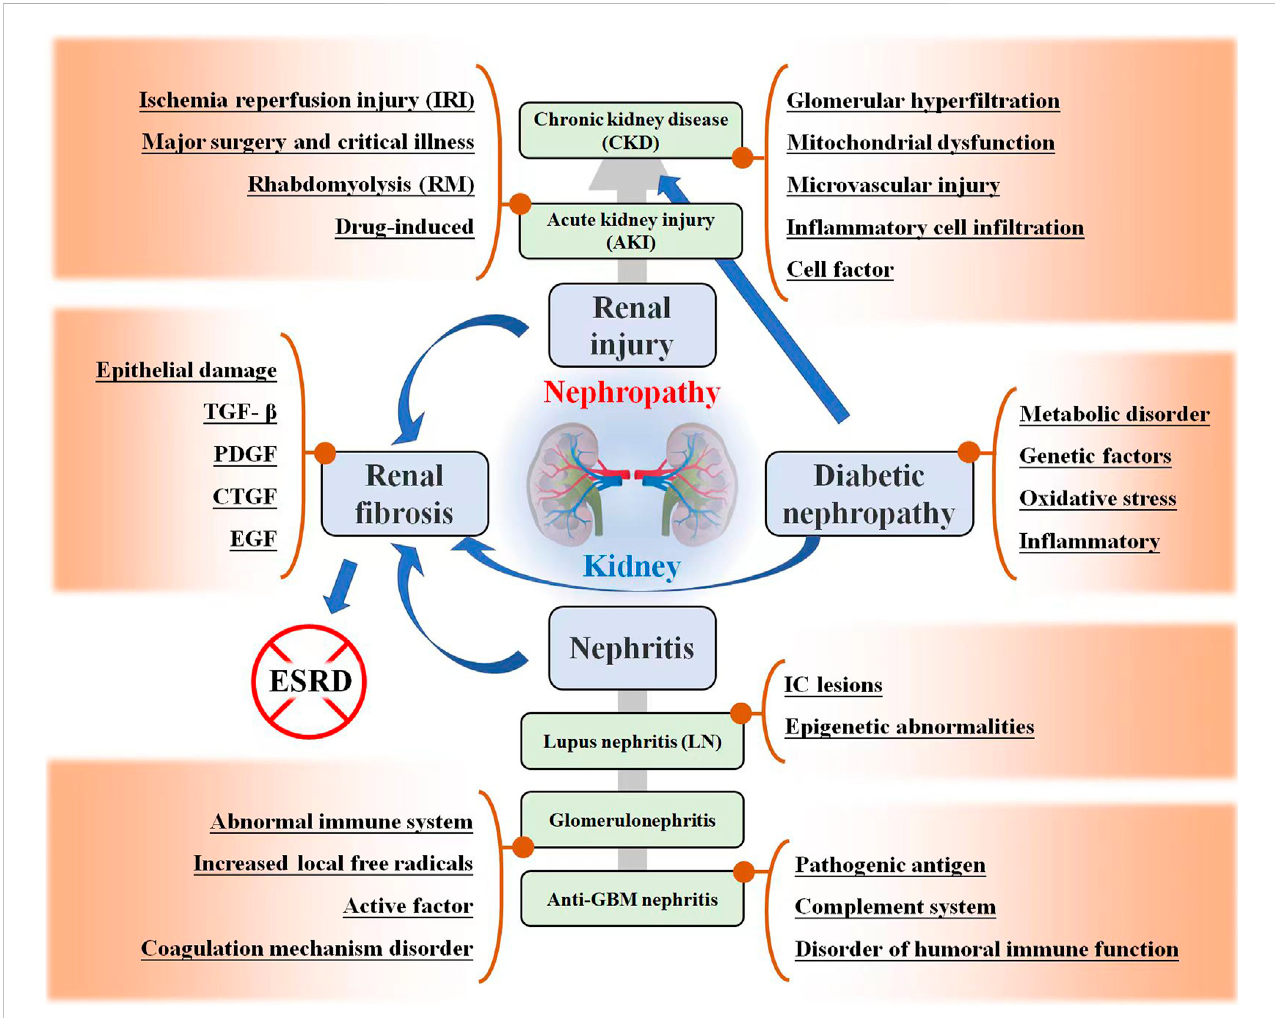
FIGURE 1 Kidney related diseases, including renal injury, renal fi brosis (RF), nephritis, and diabetic nephropathy (DN). The possible mechanisms and development trends of these diseases are listed in the fi gure.